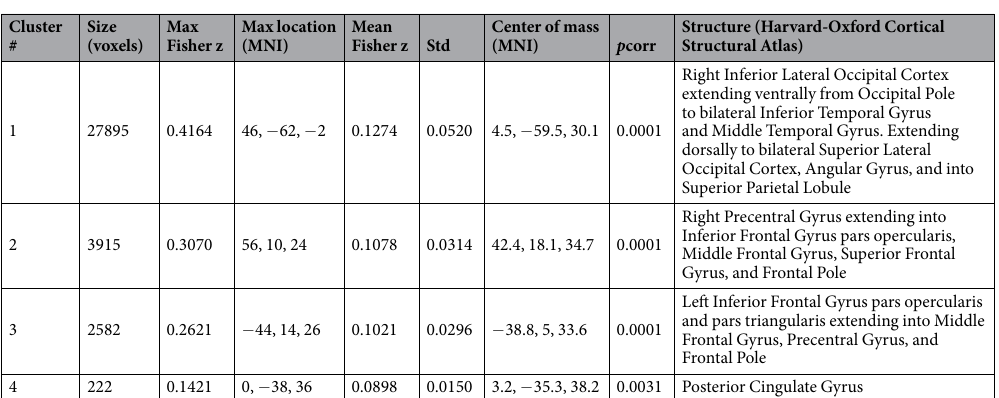
Table 2. Clusters from the delay period that showed significant correlated activity patterns with the dimension- weighted